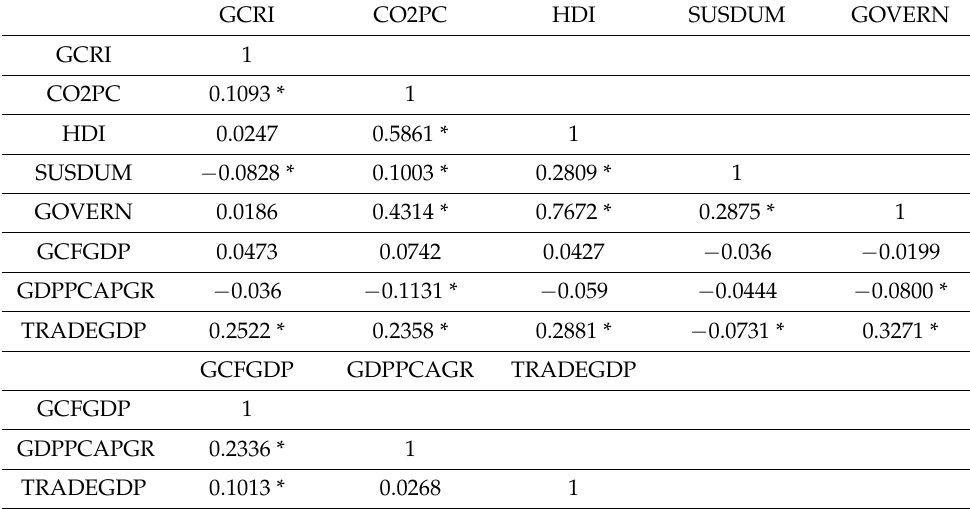
Table 2. Correlation matrix with Bonferroni adjusted significance levels at p > 0.05 level.